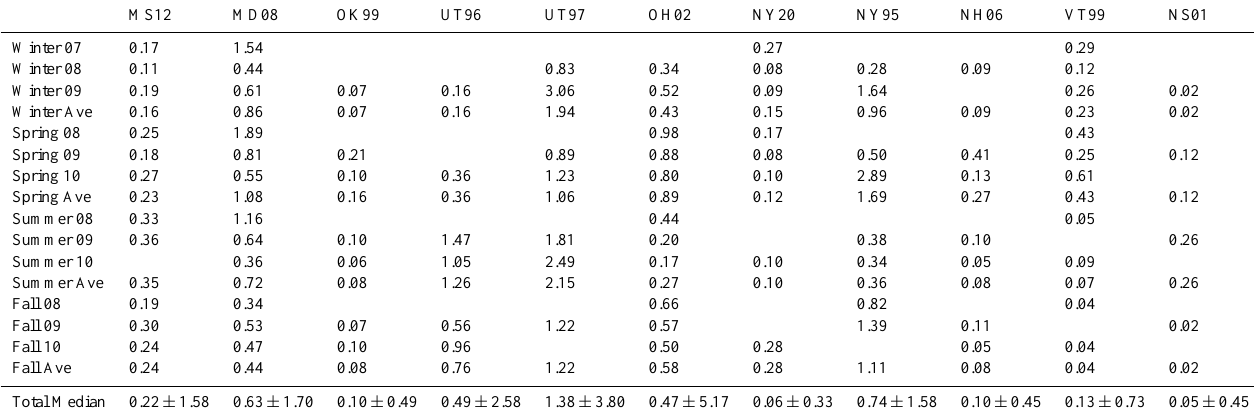
Table 3. The seasonal and total medians of GOM at 11 AMNet